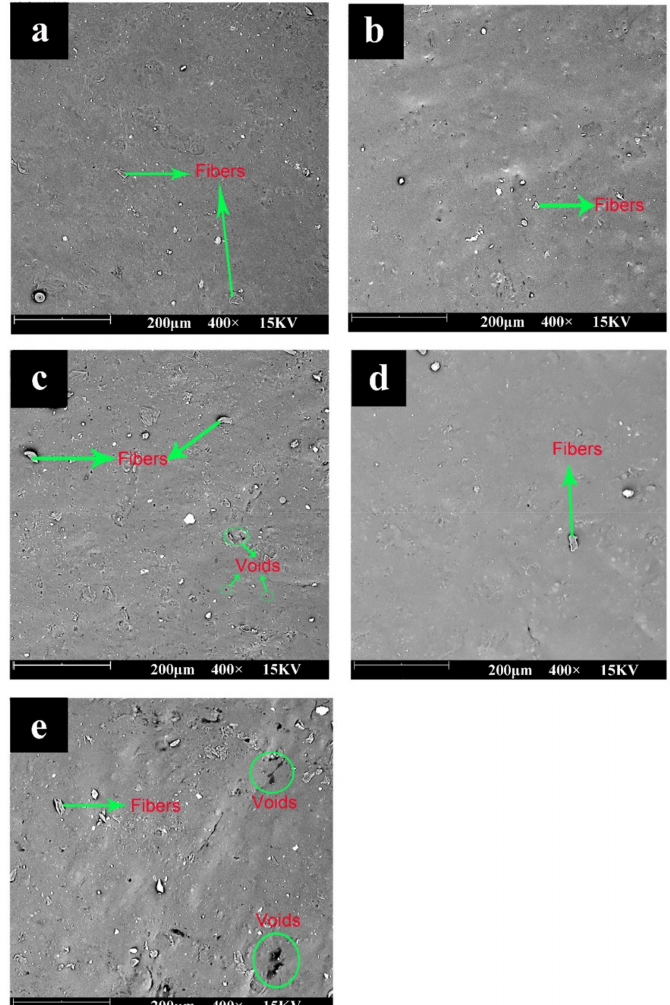
Figure 3. SEM photographs of prepared bioplastic composites: ( a ) ST-F5, ( b ) ST-F5-EPO0.75, ( c ) ST- F5-EPO3, ( d ) ST-F5-ESO0.75, and ( e )